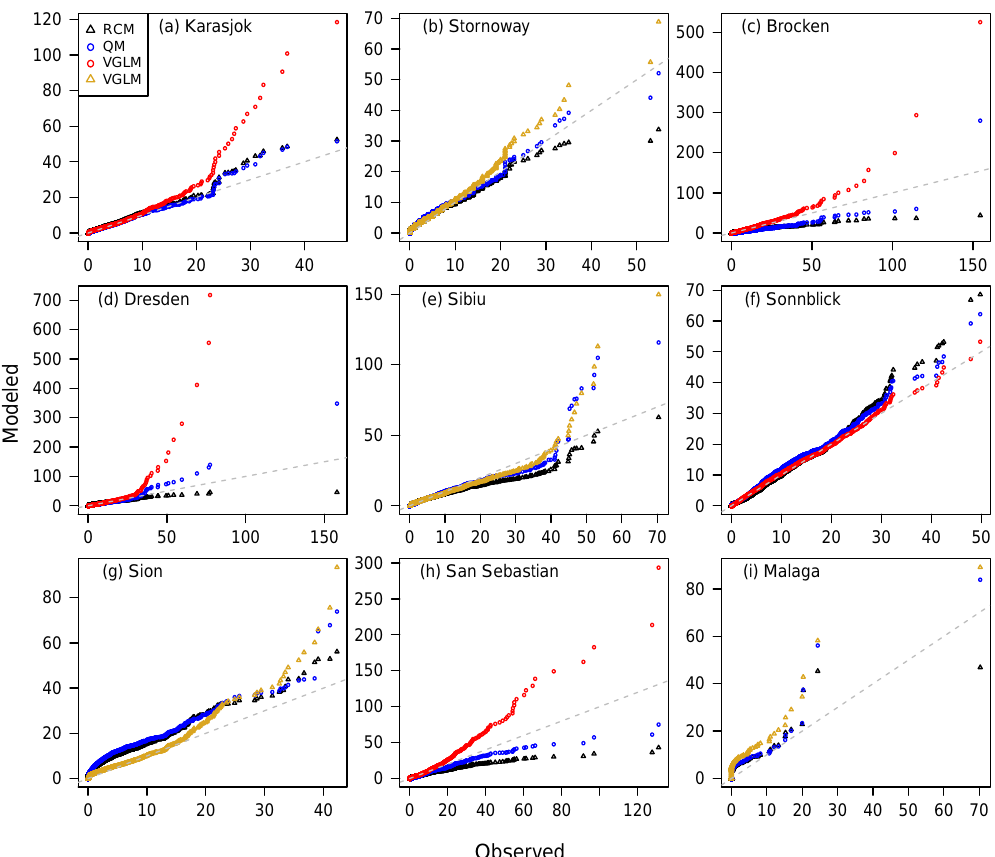
Figure B4. QQ plots for example stations of different models (cross-validated) against station observations for JJA (mmday − 1 ). (a) Karasjok, (b) Stornoway, (c) Brocken, (d) Dresden, (e) Sibiu, (f) Sonnblick, (g) Sion, (h) San Sebastian, and (i) Malaga. For the VGLM the quantiles (i.e., sorted time series) of 100 realizations are averaged. Predictor for VGLM as selected by the CvM criterion: (red circles) QM grid bias- corrected RCM, (brown triangles) uncorrected RCM. Highest VGLM-modeled quantile in Dresden out of range: 3609mmday − 1